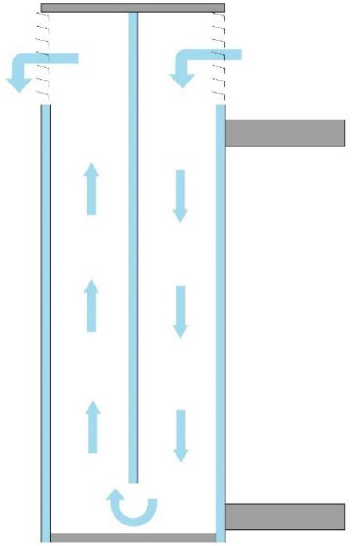
Figure 14. Triple ventilated facade with U-shaped airflow.